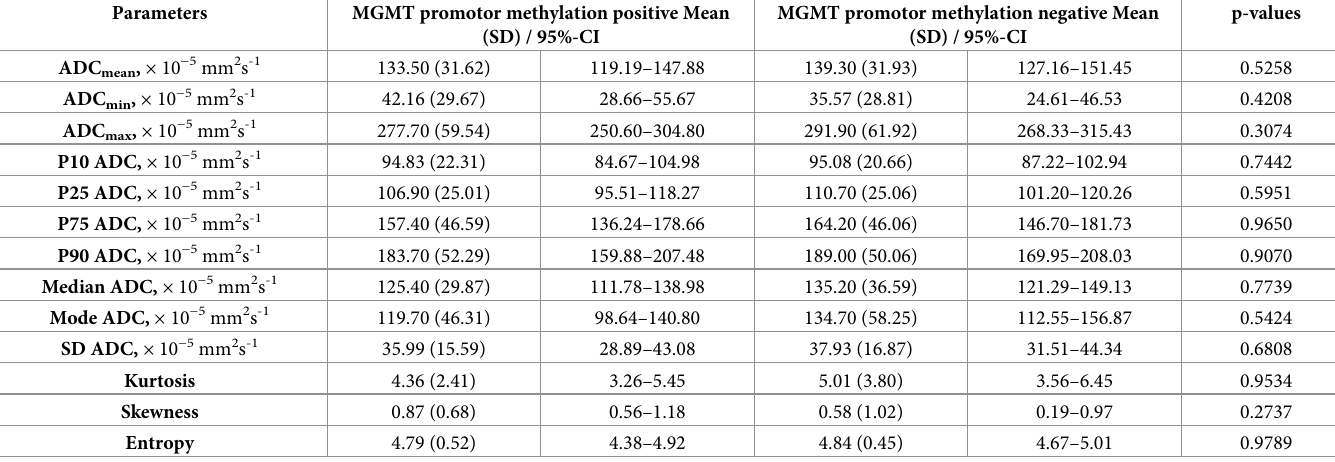
Table 3 compares DWI histogram profiling values of MGMT promotor methylation positive and negative